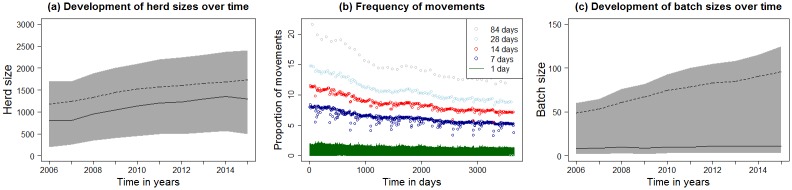
Descriptive statistics of the examined data.Figure (a) and (c) show the median (solid black line) and average (dashed black line) of holding sizes and of the number of pigs moved per pig movement sizes over time. Grey areas represent the range between 1st and 3rd quantile. Temporal trends of holding sizes for the investigated 24 holding types are shown in S1 File. Figure (b) shows the proportion of registered pig movements out of all possible movements in Denmark between 1st January 2006 and 31st December 2015 on daily base (green) and aggregated for 7 (dark blue), 14 (red), 28 (light blue) and 84 (grey) days.